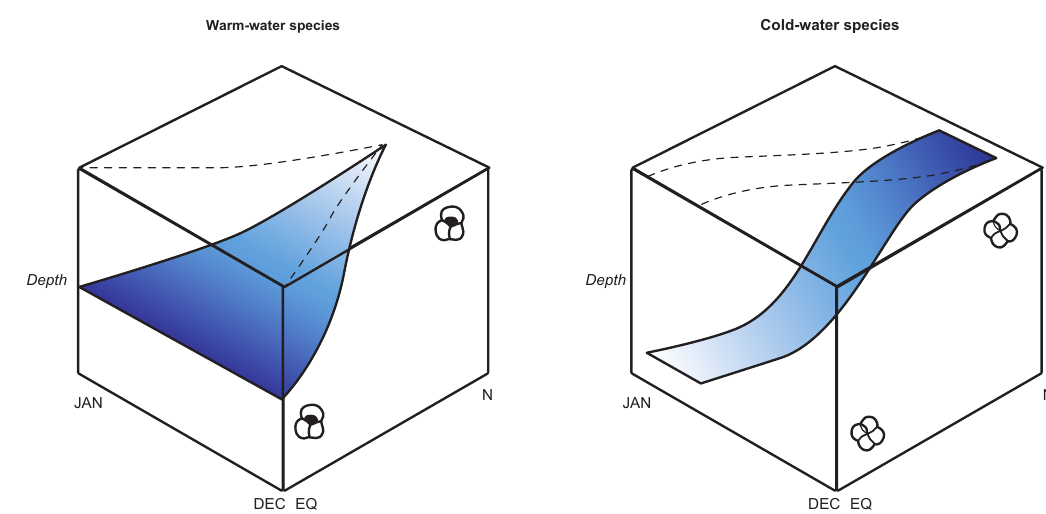
Figure 10. Conceptual model of calcification habitat change for warm- and cold-water species. The coloured plane indicates the average calcification season and depth as a function of latitude. Dashed lines on top highlight the change in the